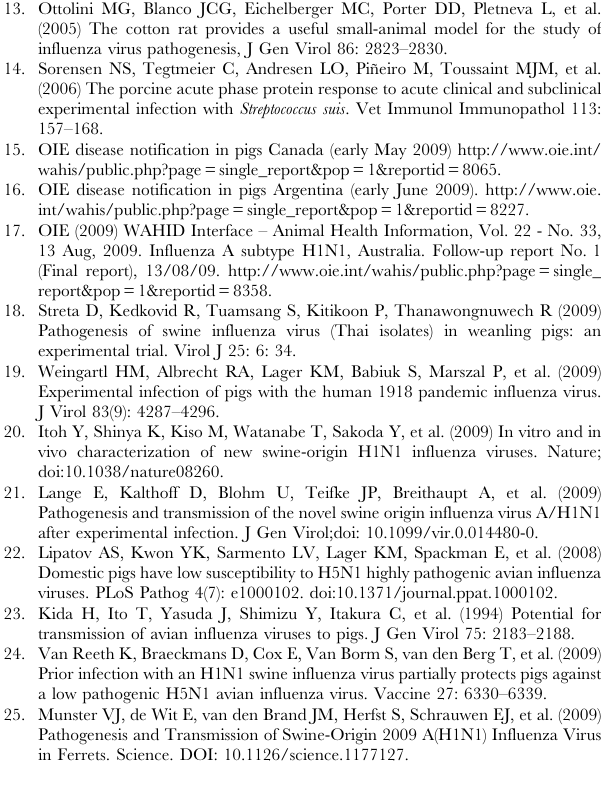
Figure S3 Mean live weight gain (kg) plus standard errors for infected (INF), transmission cycle (TC) and control (C) pigs.